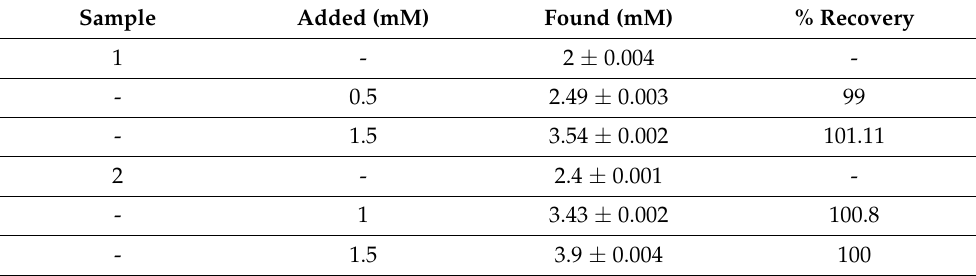
Table 7. Milk real sample analysis using % recovery method for the detection of